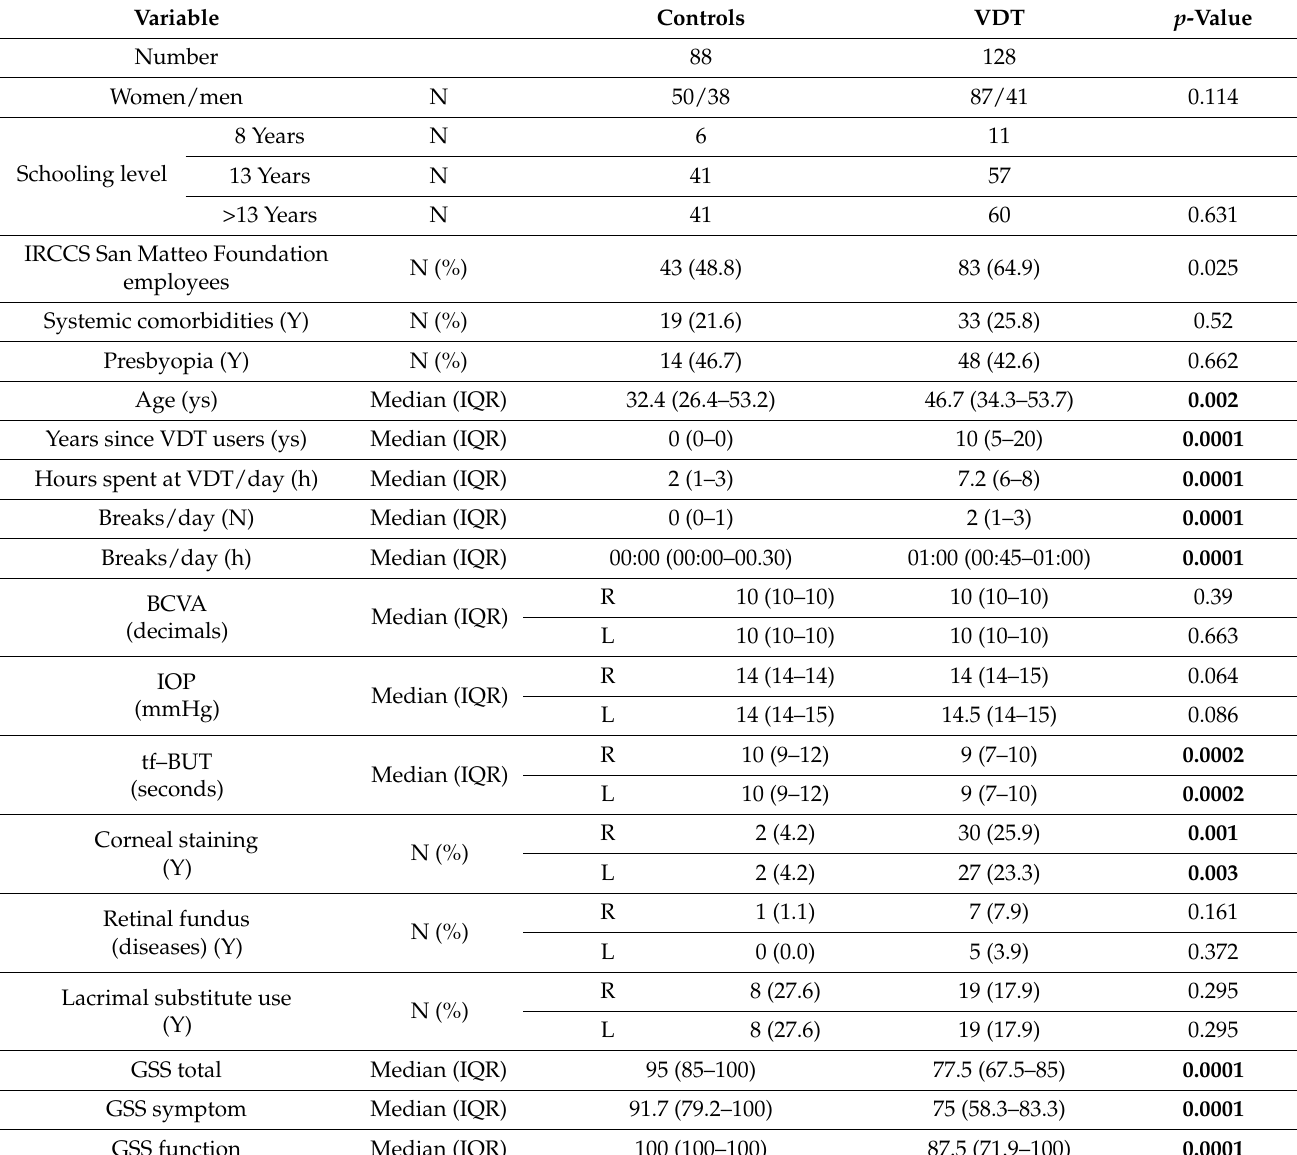
Table 1. Patients’ sociodemographic and clinical characteristics (VDT = video terminal workers; BCVA = best corrected visual acuity; IOP = intraocular pressure; tf-BUT = tear film break-up time; R = right eye; L = left eye; GSS = Glaucoma Symptom Scale; Y = yes; ys = years; h = hours; N = number; bold font: statistically significant p